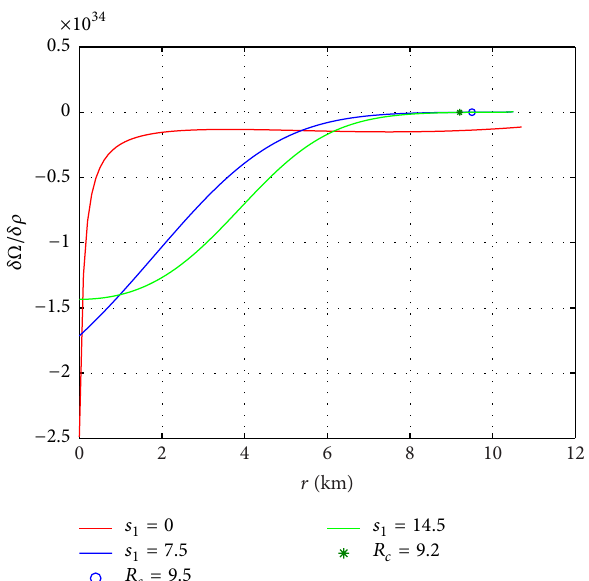
Figure 6: Cracking of PSR J1614-2230 with 𝛾 = 0.177 , 𝛼 = 0.15 , and 𝑠